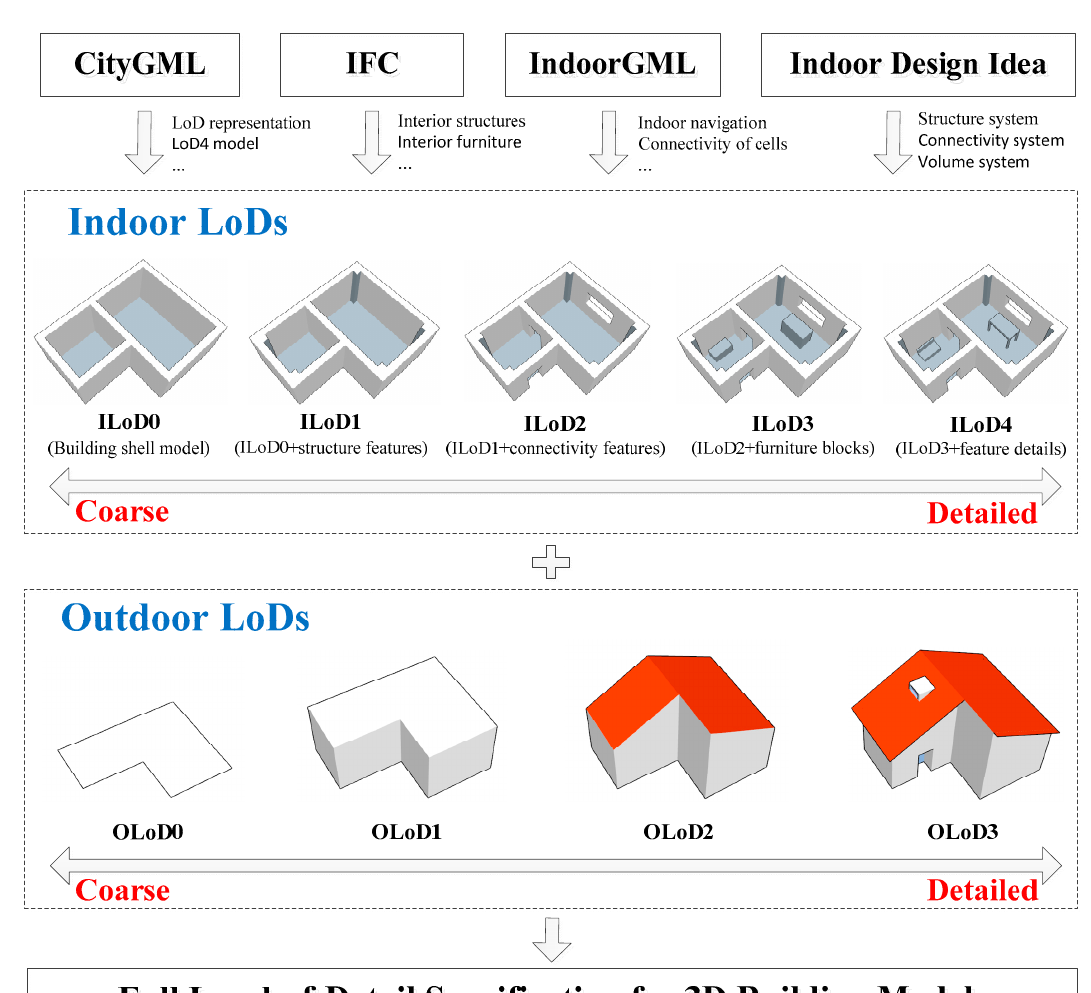
Figure 2. Research route of full level of detail (LoD) specification for 3D building models. IFC, (industry foundation classes); ILoD (indoor LoD); OLoD (outdoor LoD).